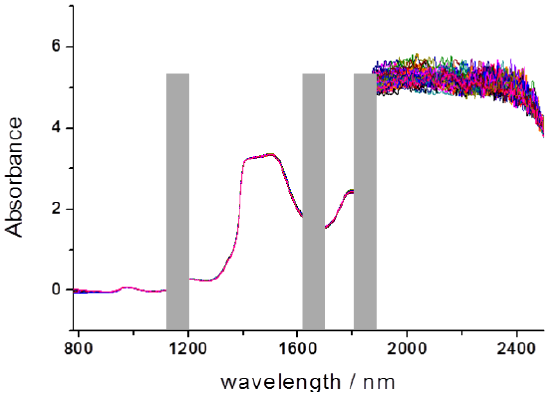
Fig. 5. The results of siPLS.